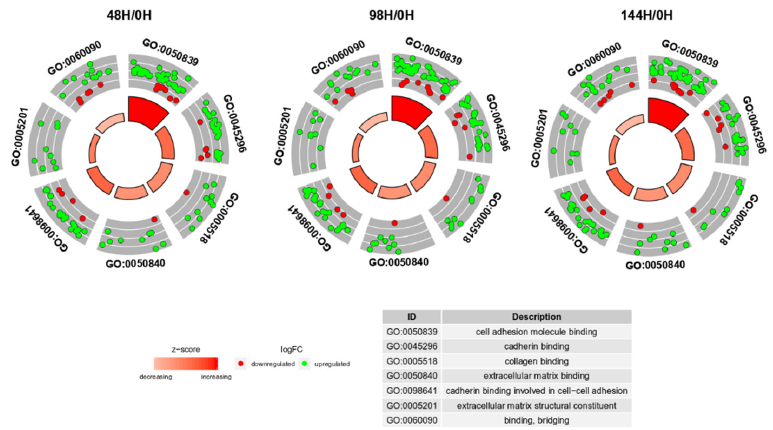
Figure 3. The circular scatter plots of differentially expressed genes involved in “extracellular matrix binding”, “extracellular matrix structural constituent”, “binding, bridging”, “cadherin binding”, “cell adhesion molecule binding”, “collagen binding” and “cadherin binding involved in cell-cell adhesion” GO MF terms. Each dot represents a single gene. The z-scores were presented as segments of inner circles.